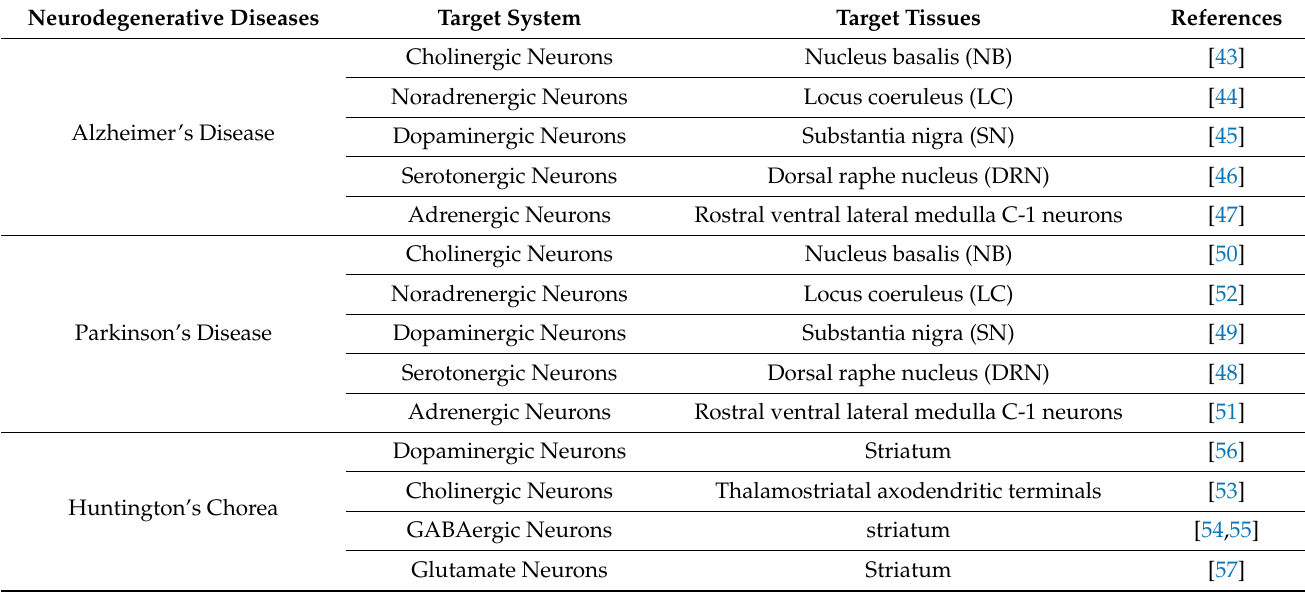
Table 1. Vulnerable neuronal populations in various neurodegenerative diseases.